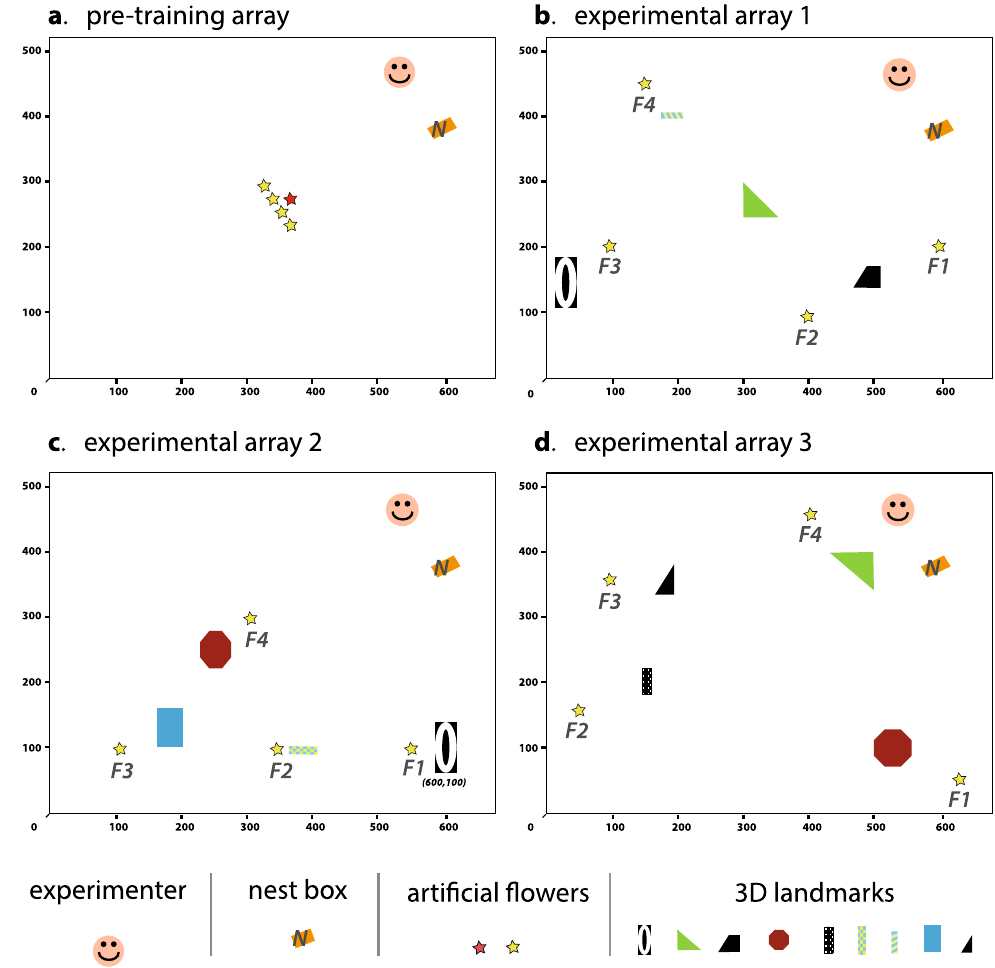
Figure 1. Experimental arrays of flowers and landmarks. ( a ) Pre-training array. Bees were allowed to forage on a pre-training flower (red star) in a landmark-free environment for one hour. A selected bee was then observed foraging on four training flowers (yellow stars) during five foraging bouts to estimate its nectar crop capacity. ( b – d ) show the first, second and third experimental arrays used for testing. Each array was characterised by a unique combination of four training flowers (F1-F4) and three to four landmarks (coloured shapes). Detailed descriptions of the artificial flowers and the 3D landmarks are given in Figs S1 and S2. X- and Y-axis graduations represent the distance to the origin (down left corner) in